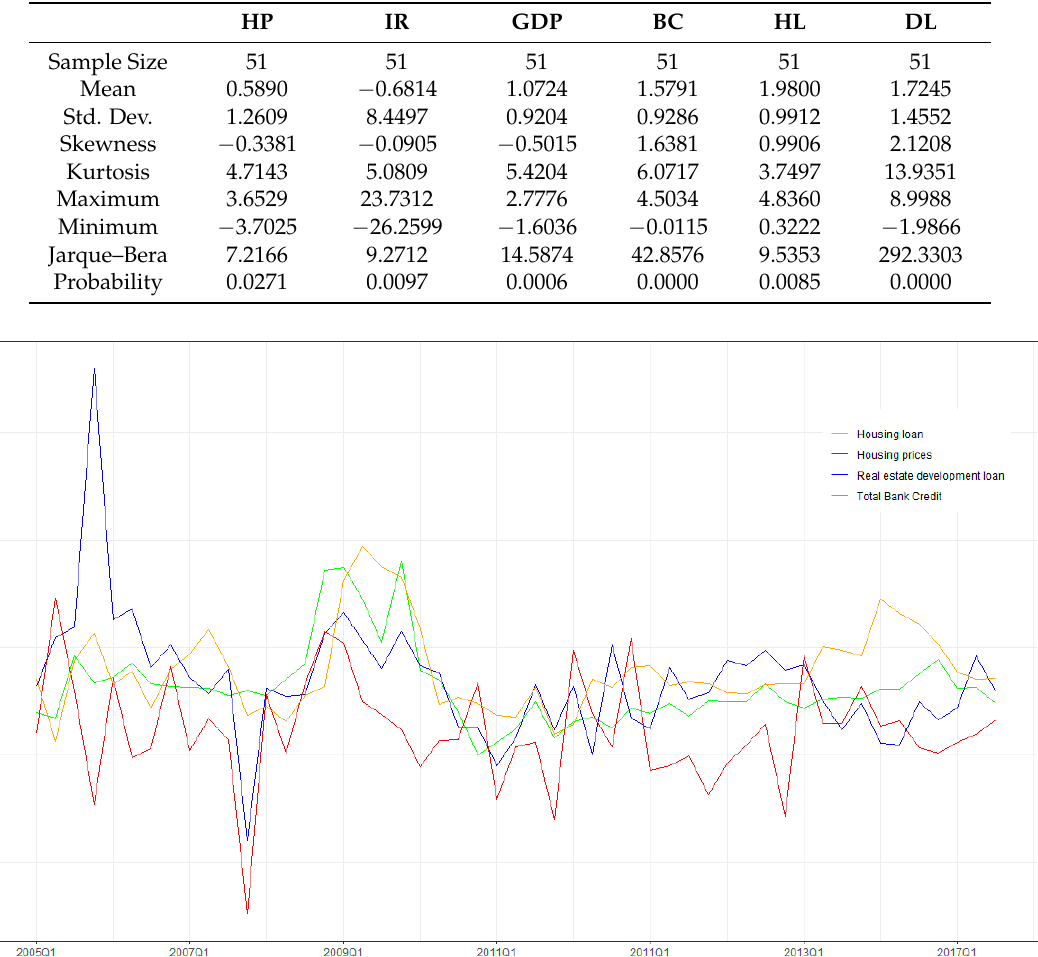
Table 2. Descriptive statistics.